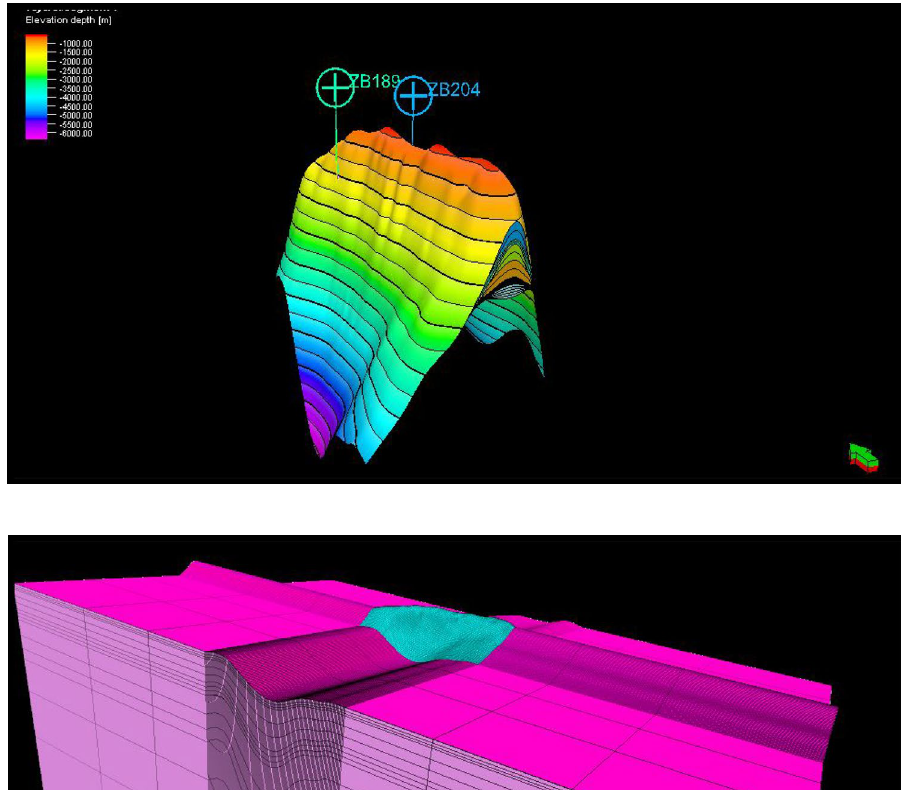
Fig. 6 Zubair oilfield reservoir grid